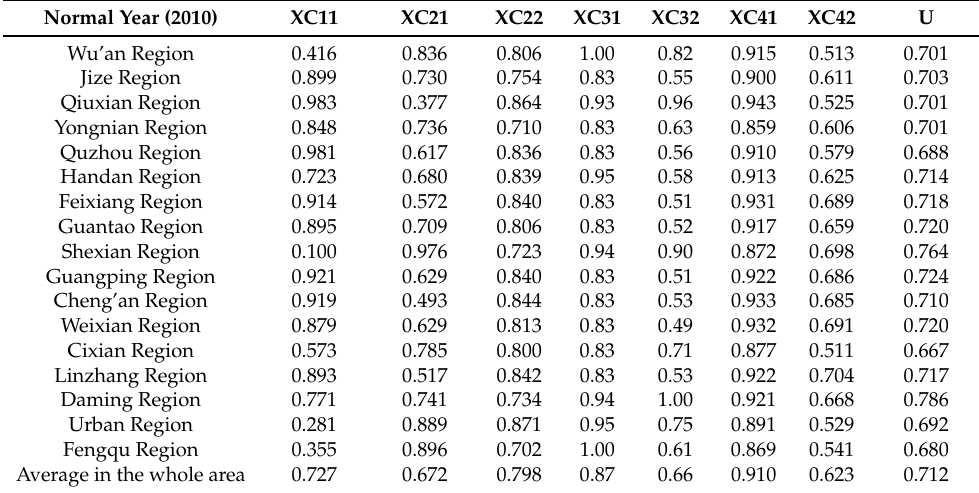
Table 7. Standard values of the second-class indices and the total SWA of different regions in the normal year (2010).